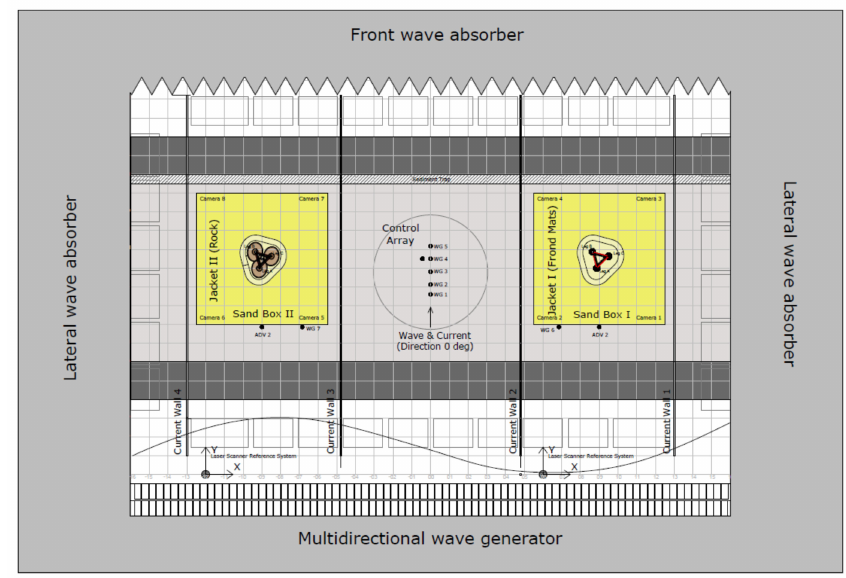
Figure 3. Basin setup.